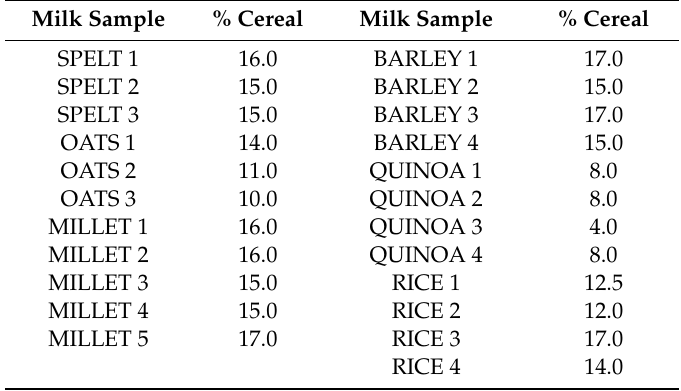
Table 1. Declared cereal concentration (%) of milk